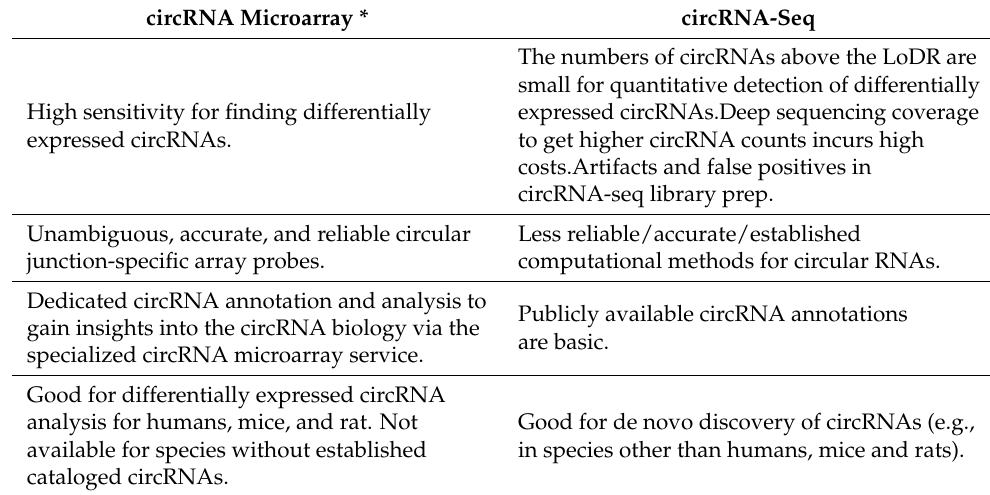
Table 9. Comparison of the circRNA microarray and circRNA-seq for circRNA expression profiling. circRNA Microarray *